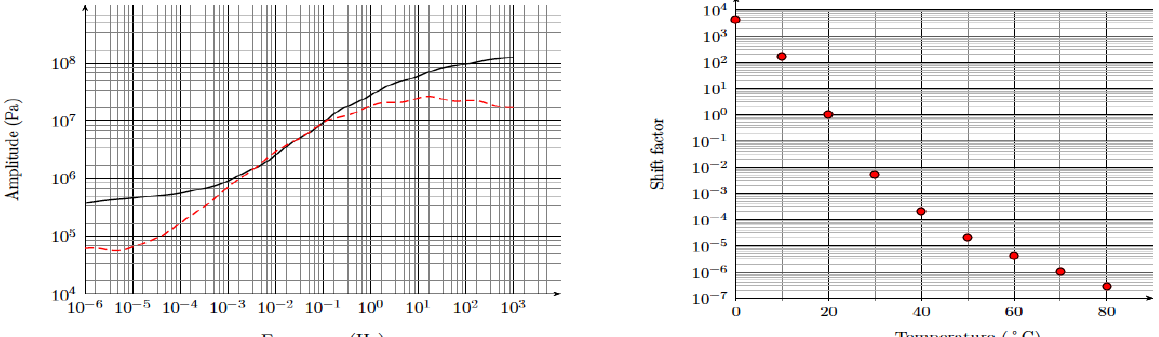
Fig. 3 Viscoelastic properties the PVB. Left : Shear modulus  versus frequency ; Elastic  r (line) and loss  i (dashed) modulus at the temperature  = 30°C. Right : Shift factor a  versus